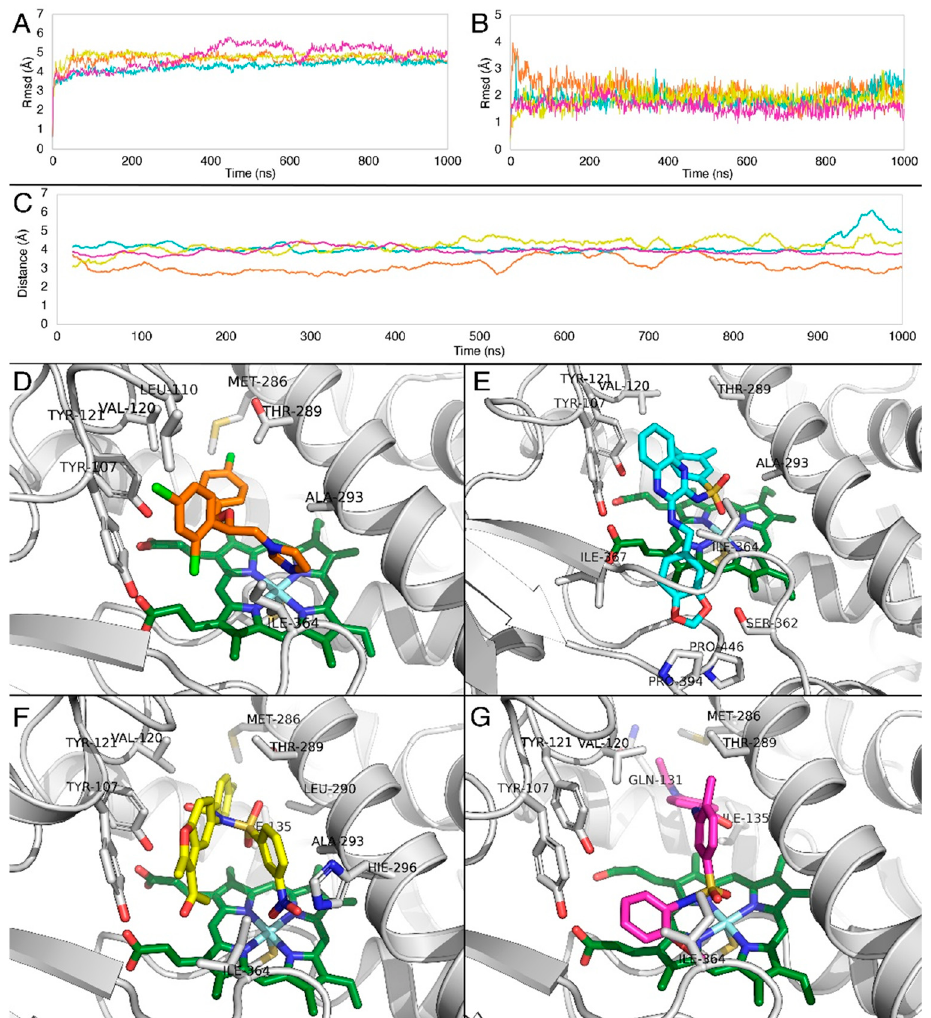
Figure 10. RMSD of ( A ) C α atoms of CYP51A, ( B ) ligands along the MD trajectory. Graph colors correspond to the coloring of the four ligands. ( C ) Averaged distances obtained from the molecular dynamics between the heme iron and imidazole nitrogen of R-econazole (orange), center of mass of the two sulfonyl oxygens of compound 1 (cyan), center of mass of the two nitro group oxygens of compound 2 (yellow) and the center of mass of the two sulfonyl oxygens of compound 4 (magenta). Representative complexes obtained from the MD simulations of Aspergillus fumigatus CYP51A with ( D ) R-econazole (orange), ( E ) compound 1 (cyan), ( F ) compound 2 (yellow), and ( G ) compound 4 (magenta). The heme molecule is represented in green.